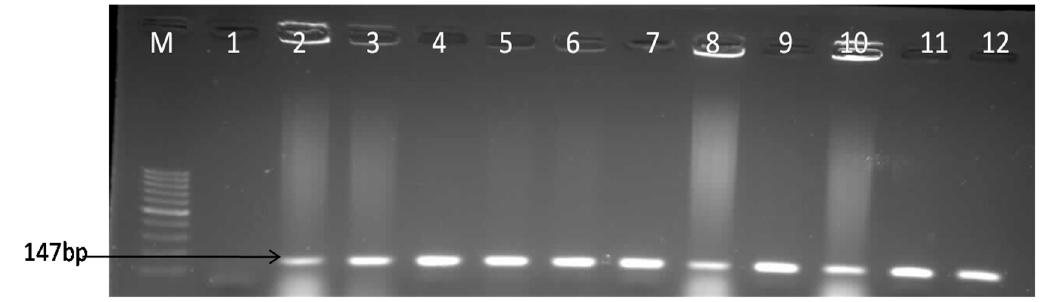
Figure 1. Gel image for the molecular confirmation of E. coli isolates using the uidA (147bp) gene. Lane M: 100bp DNA ladder, Lane 1: Negative control, Lane 2–12 samples.